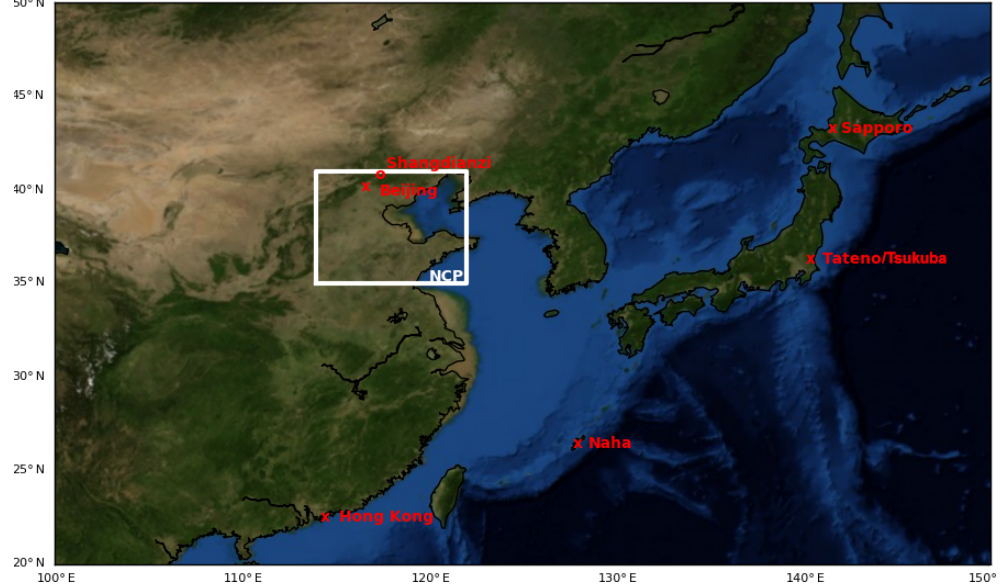
Figure 1. Localization of the NCP region considered in the study. The study region is indicated by the large square in addition to the surface (o) and ozonesonde (x) stations. Tateno/Tsukuba is referred to as Tateno throughout this